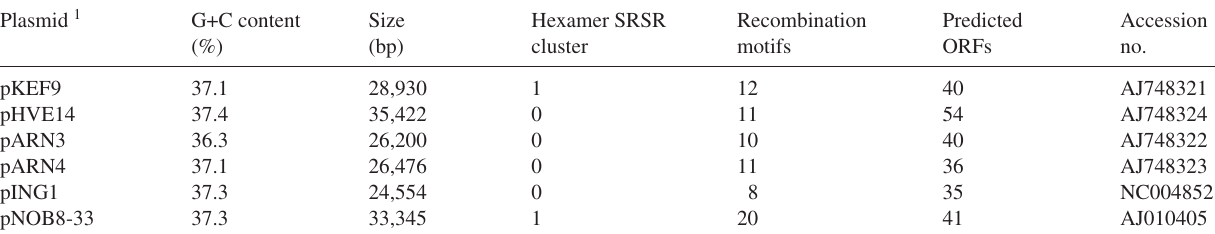
Table 1. Sulfolobus self-transmissableplasmids used in this study. Abbreviations: SRSR = short regularly spaced repeat; and ORF = open reading